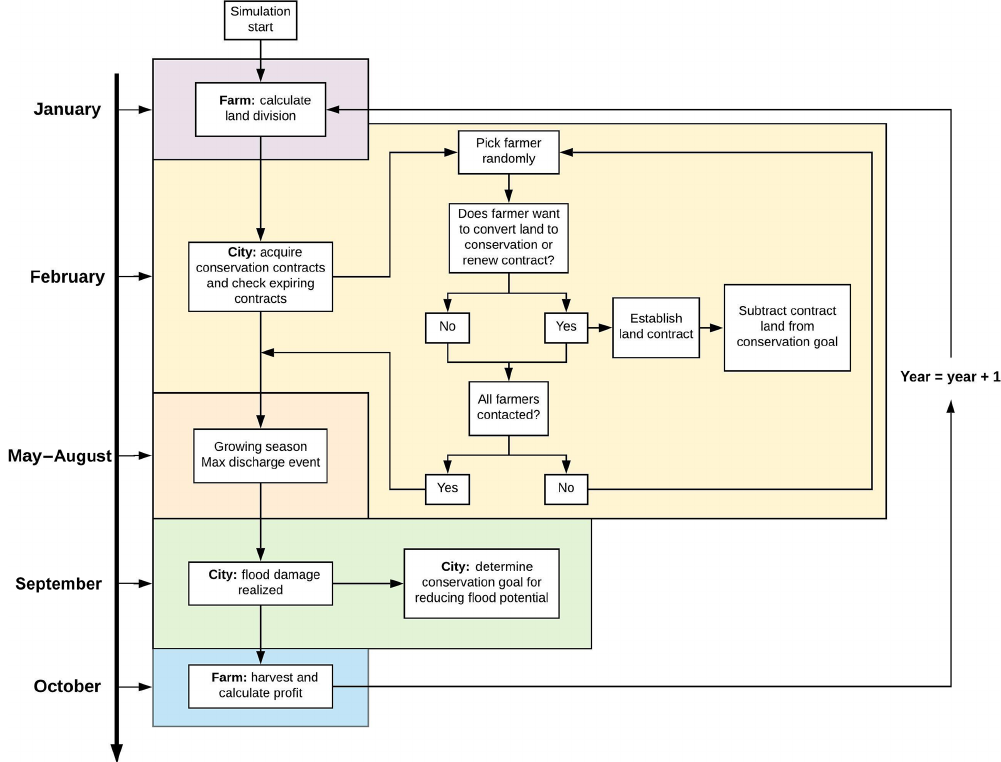
Figure 2. Timeline of agent decisions and actions within the agent-based